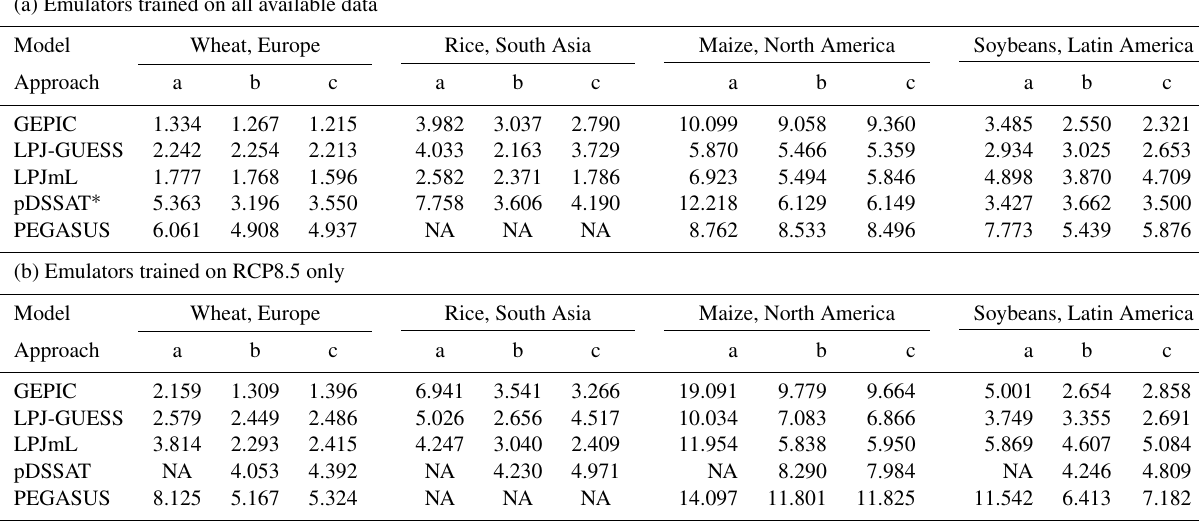
Table 3. Root-mean-square difference between emulated and simulated decadal production (expressed as a percentage of the simulated production as in Fig. 9) in the largest producing region of each crop, for all five crop models forced by HadGEM2-ES climate projections. Average across all four RCPs. The values for all combinations of models, crops, and regions, and separately for each RCP, can be found in the Supplement. Top: emulators trained on all available data; bottom: emulators trained on RCP8.5 only. (a) Emulators trained on all available